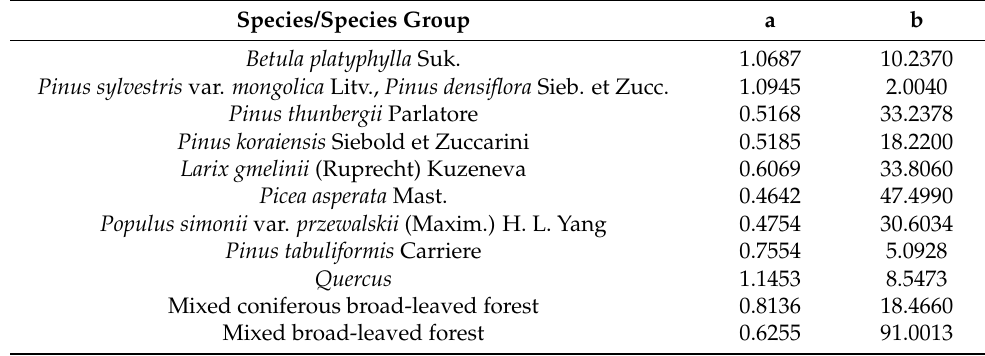
Figure 2. ( a ) Study area in Jinlin Province, China; ( b ) false color image of Landsat OLI; and ( c ) the distribution of forest types. Table 1. The parameters of conversion model between AGB and forest stock volume [44].